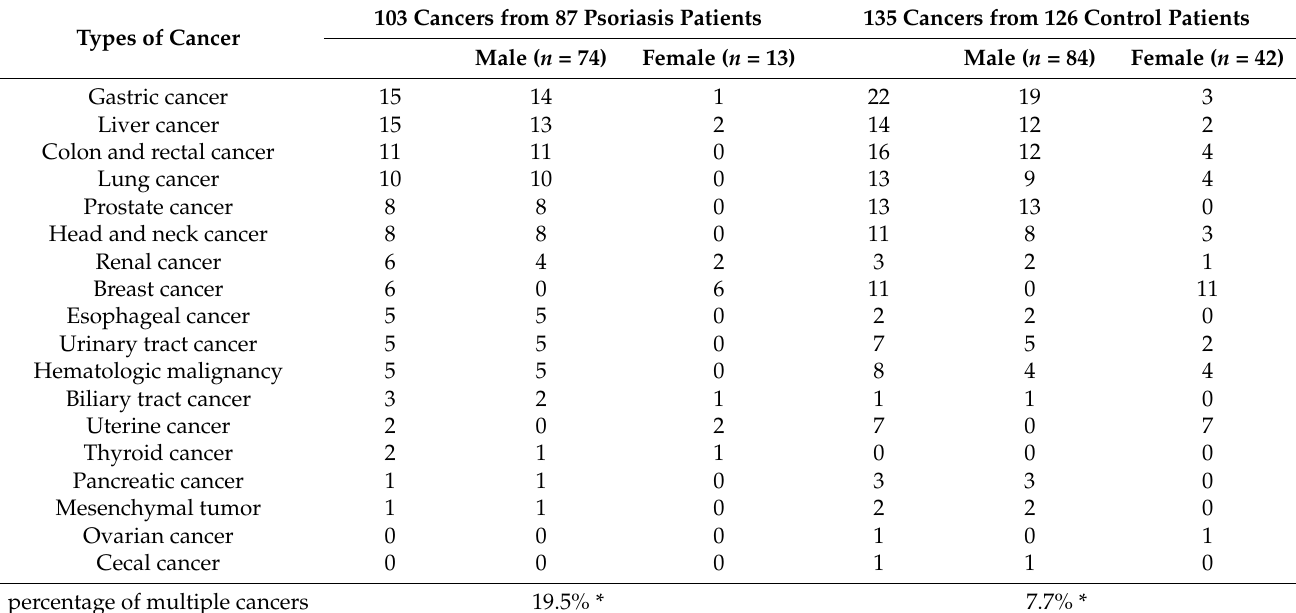
Table 1. Types of cancer associated with psoriasis and control patients.